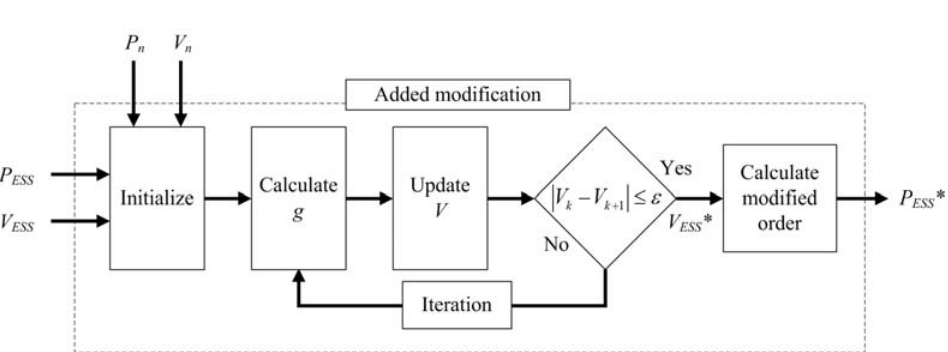
Figure 4. Modified control diagram of iterative method.